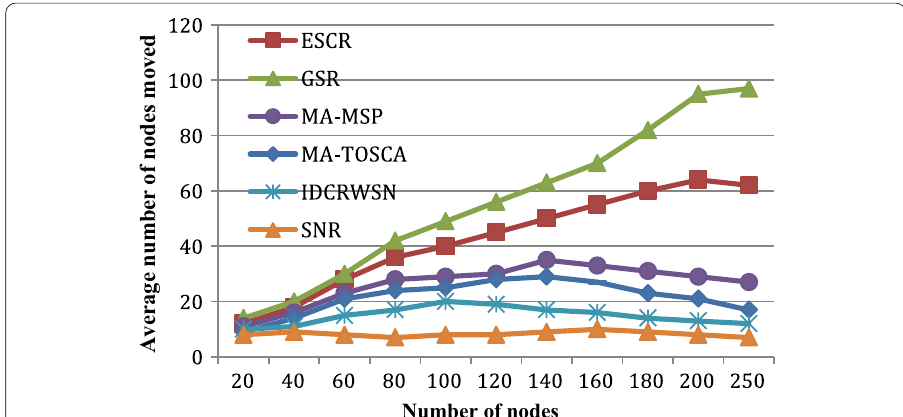
Fig. 10 The average number of nodes moved during recovery